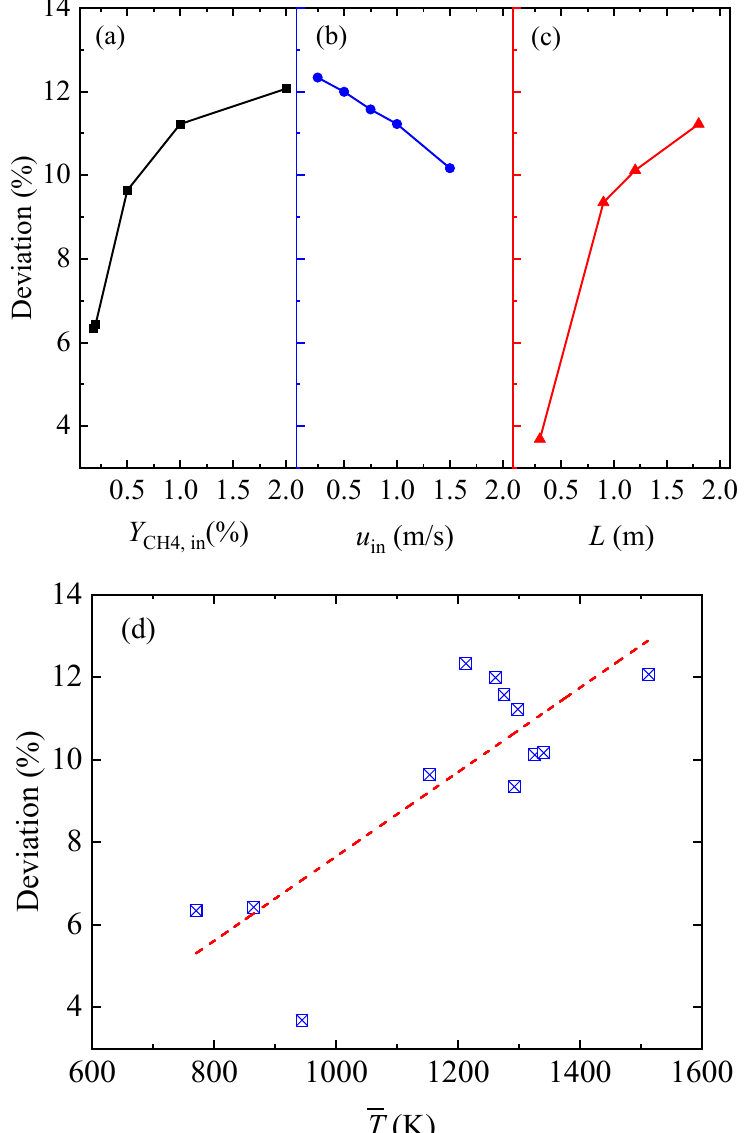
Figure 7. Deviations between the theoretical and simulation results for all cases: ( a ) various inlet methane volume fractions, ( b ) various gas velocities, ( c ) various conduit lengths, and ( d ) various mean gas temperatures.